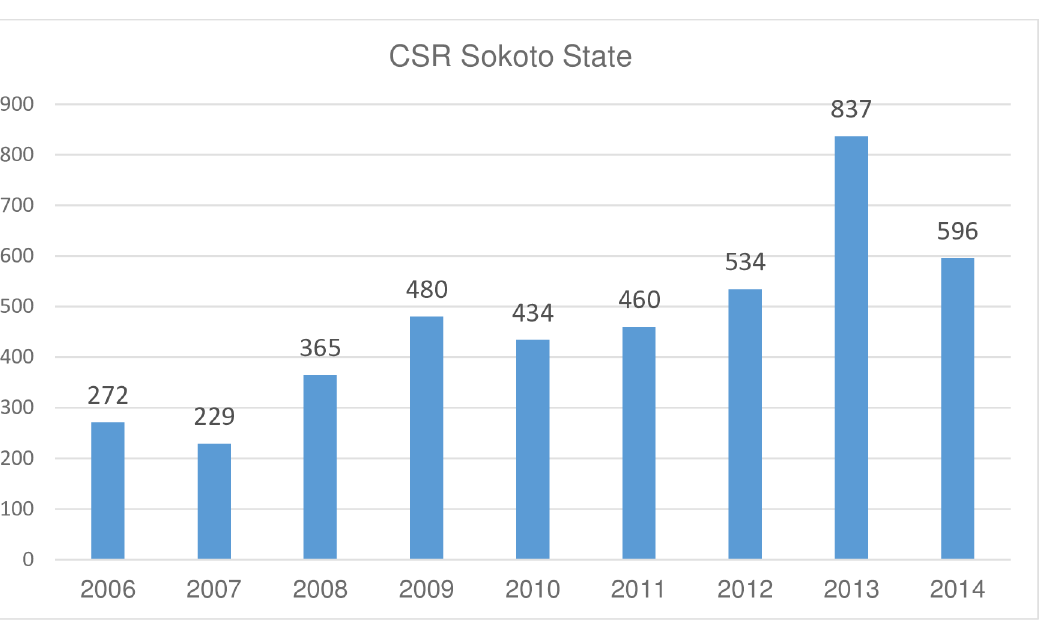
Fig 1. Trends in CataractSurgical Rate, Sokoto State,